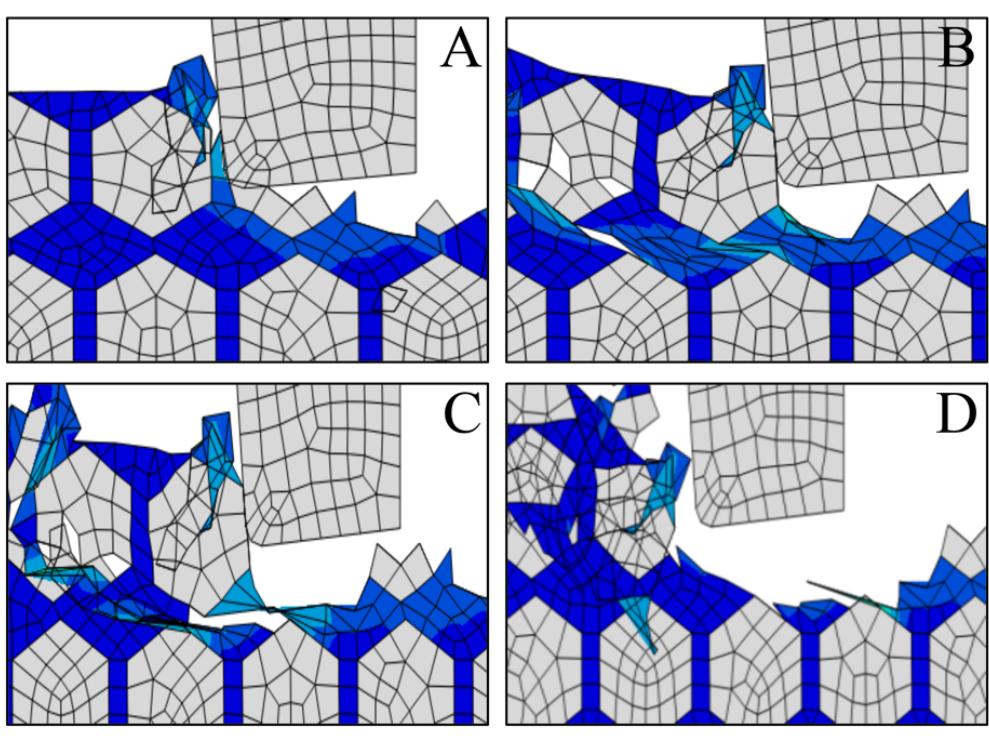
Figure 23. ( A – D ) Schematic diagram of the formation process of a deep pit.